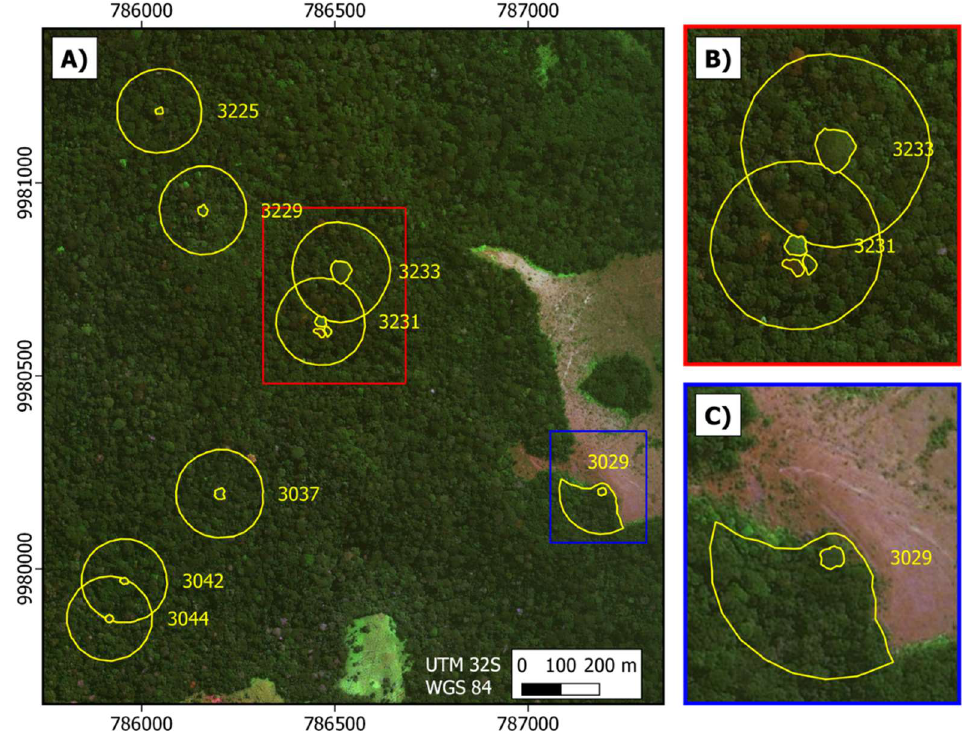
Figure 3. Aerial view of eight focal Moabi crowns at Lop é NP, Gabon (small yellow circles) and their 100-m bu ff ers (surrounding yellow circles). ( A ). Focal Moabi crowns were identified and drawn by hand using GPS coordinates from the ground and high resolution ( < 2 m pixels) imagery available in the Google Earth ™ and Microsoft Bing ™ platforms. We delineated forest in a 100-m bu ff er around the crown boundary of each focal tree, erasing the focal crown and other Moabi crowns contained within the bu ff er. ( B ). Tree 3231 is adjacent to two Moabi crowns, which are not part of this study but were excluded from the 3231-forest bu ff er to avoid signal contamination. ( C ). Tree 3029 sits at the forest-savanna edge and thus c.a. 58% of the bu ff er was excluded due to being within the savanna. Background imagery is provided by ESRI World